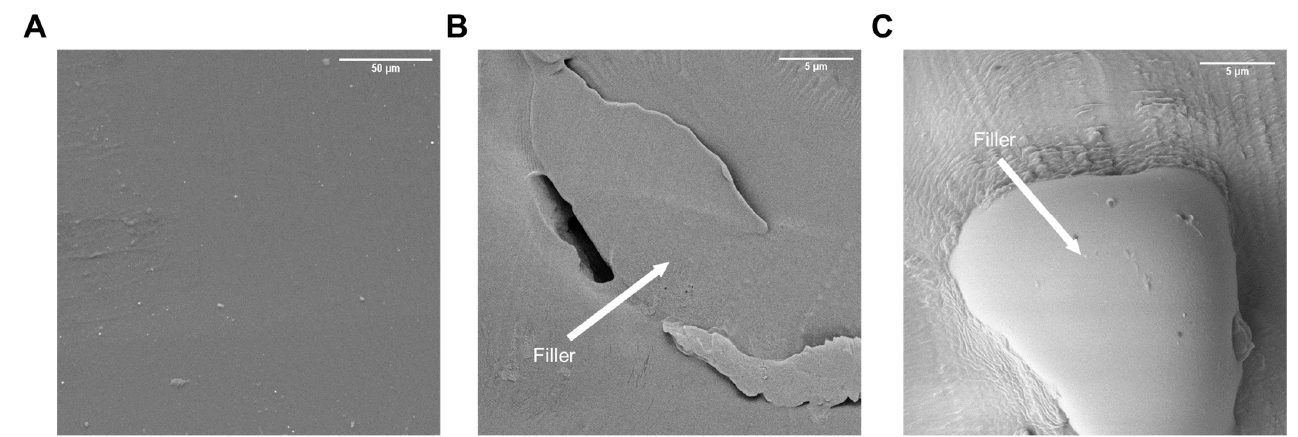
Figure 5. Representatives SEM images of P1 polyurethane composites at ( A ) 0%-AL, ( B ) 3%-AL-N, and ( C ) 3%-AL-Z.